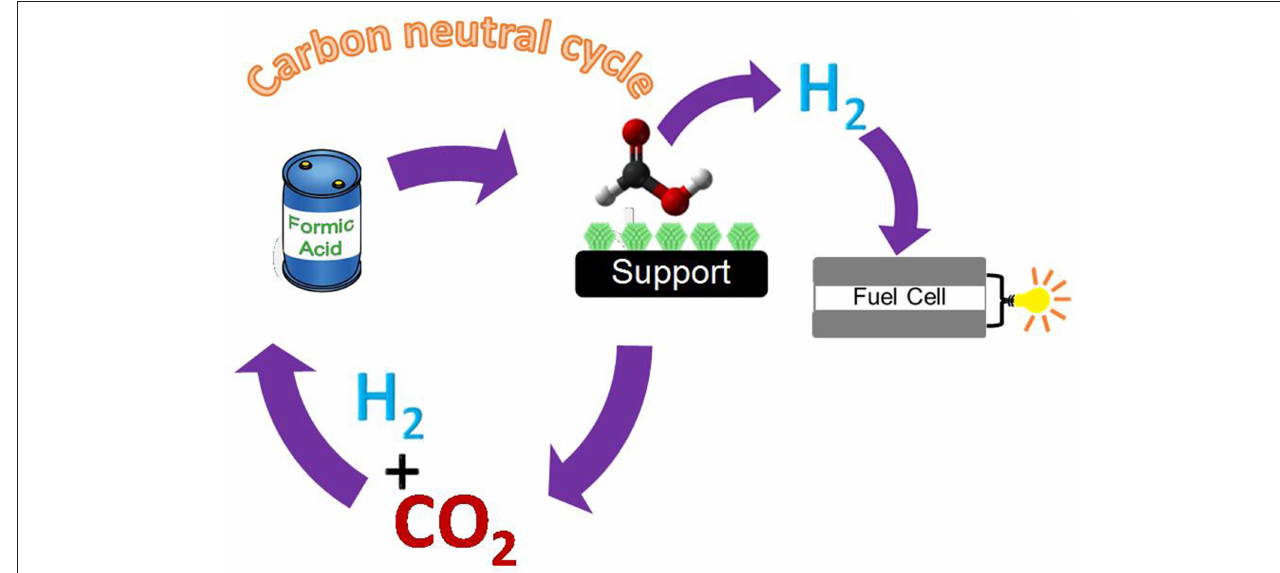
FIGURE 1 | Carbon-neutral energy storage using formic acid as a hydrogen carrier